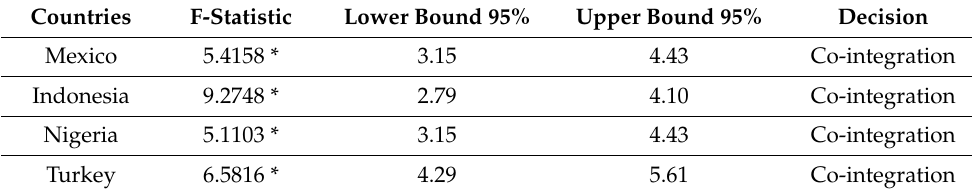
Table 5. NARDL Co-integration.